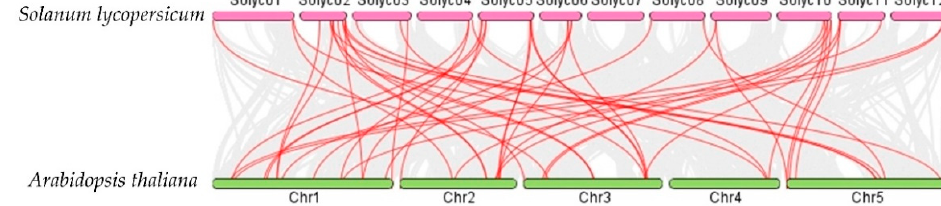
Figure 7. Syntenic analysis between AAt regions of Solanum lycopersicum and Arabidopsis thaliana . Gray lines in the background indicate collinear blocks between Solanum lycopersicum and Arabidopsis thaliana , while red lines highlight syntenic AAT gene pairs.